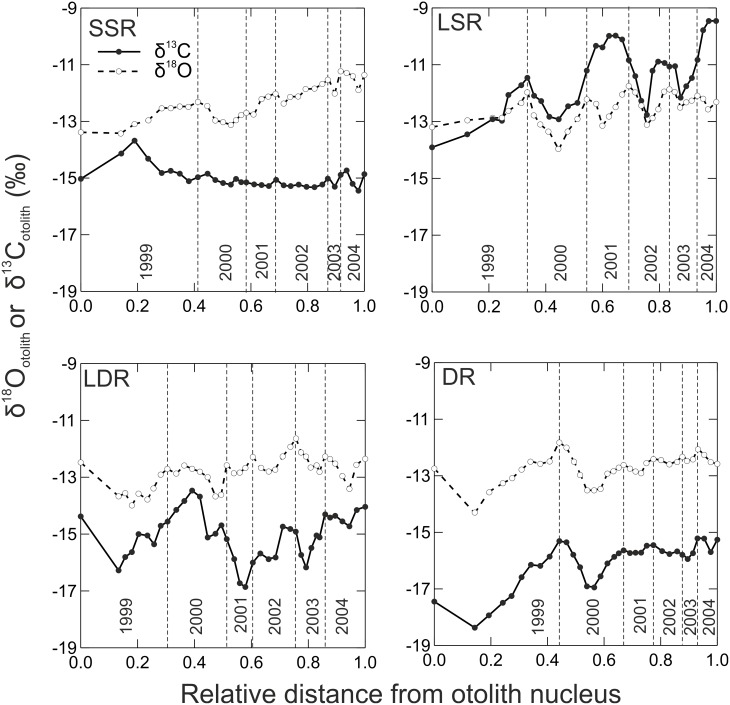
δ18O and δ13C values estimated from individual whitefish morph otoliths (SSR = small sparsely rakered, LSR = large sparsely rakered, LDR = large densely rakered and DR = densely rakered whitefish).The first x-axis value indicates the nucleus.